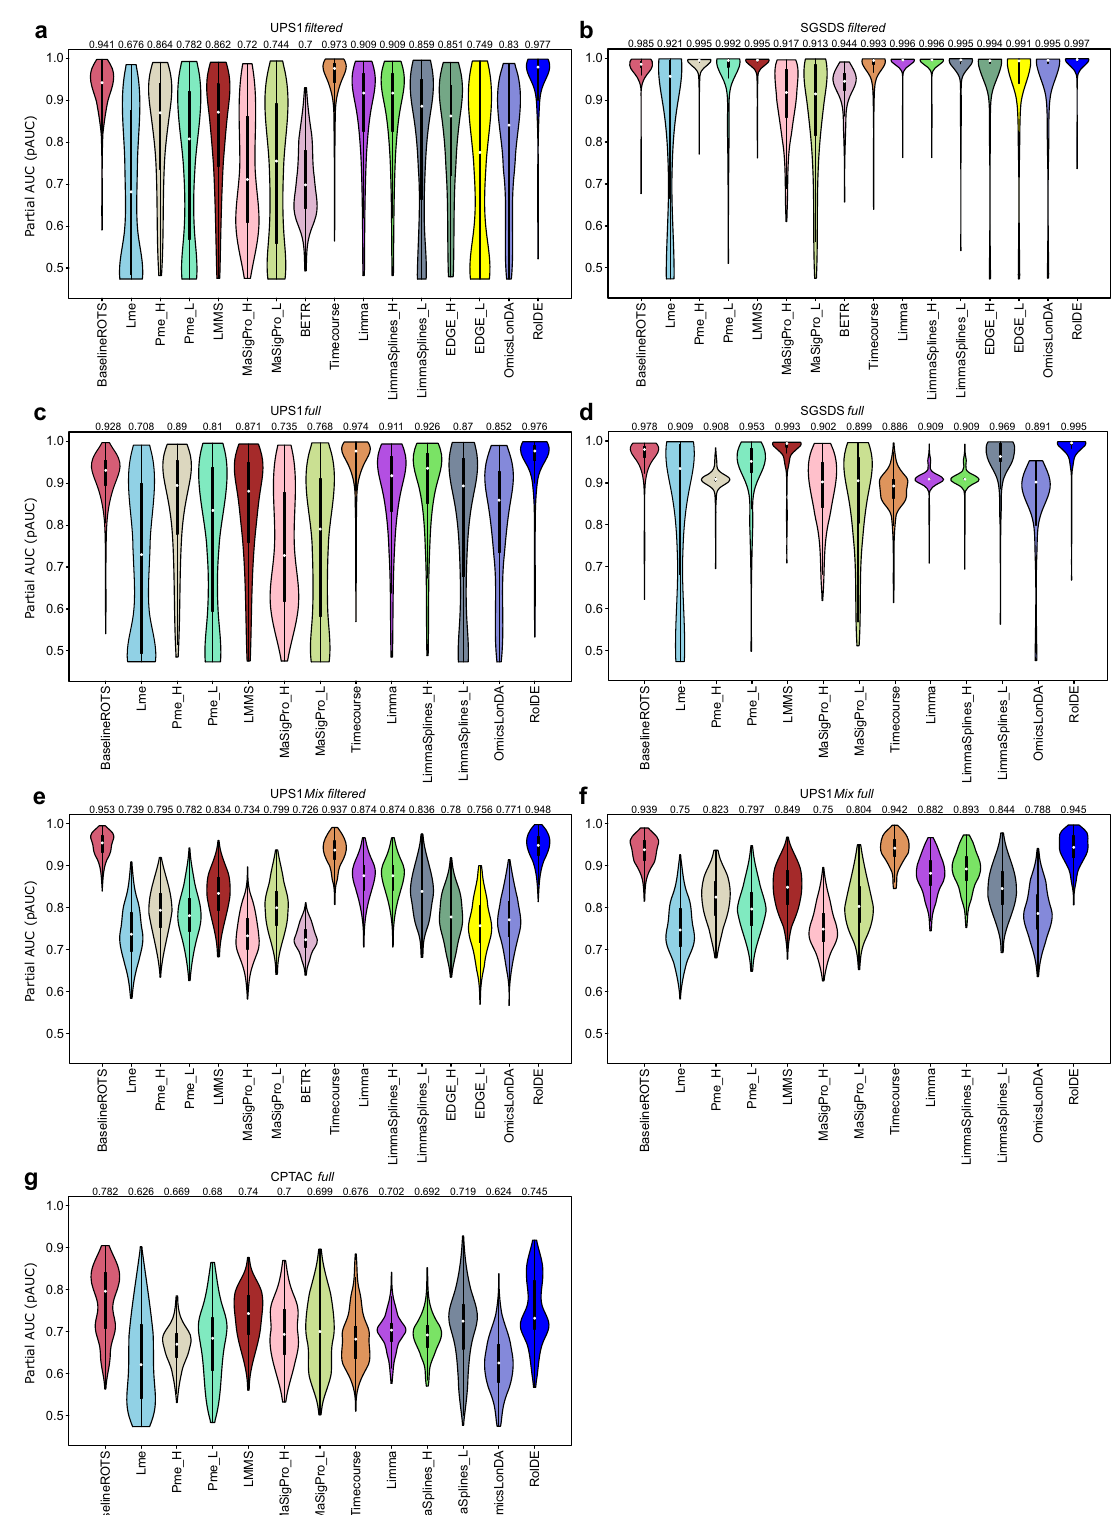
Fig.2|Theperformanceoftheexaminedmethodsinthesemi-simulatedspike- in datasets. a UPS1 fi ltered ( n =300 datasets), b SGSDS fi ltered ( n =210 datasets), c UPS1 full ( n =300 datasets), d SGSDS full ( n =210 datasets), e UPS1 Mix fi ltered ( n =300 datasets), f UPS1 Mix full ( n =300 datasets), g CPTAC full ( n =300 data- sets). The methods were examined in their ability to detect true (known) long- itudinal differential expression using receiver operating characteristic (ROC) analysis across datasets with varying longitudinal trend differences in the spike-in